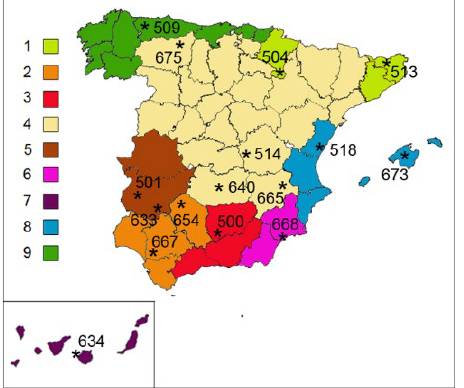
Figure 1. The collecting site location ( ⁎ ) of 16 Spanish landraces of T. turgidum in nine (1–9) agroe- cological zones of Spanish territory represented with different colours. The three numbers located next to each locality are the last three digits of the corresponding accession (first column of Table 1).